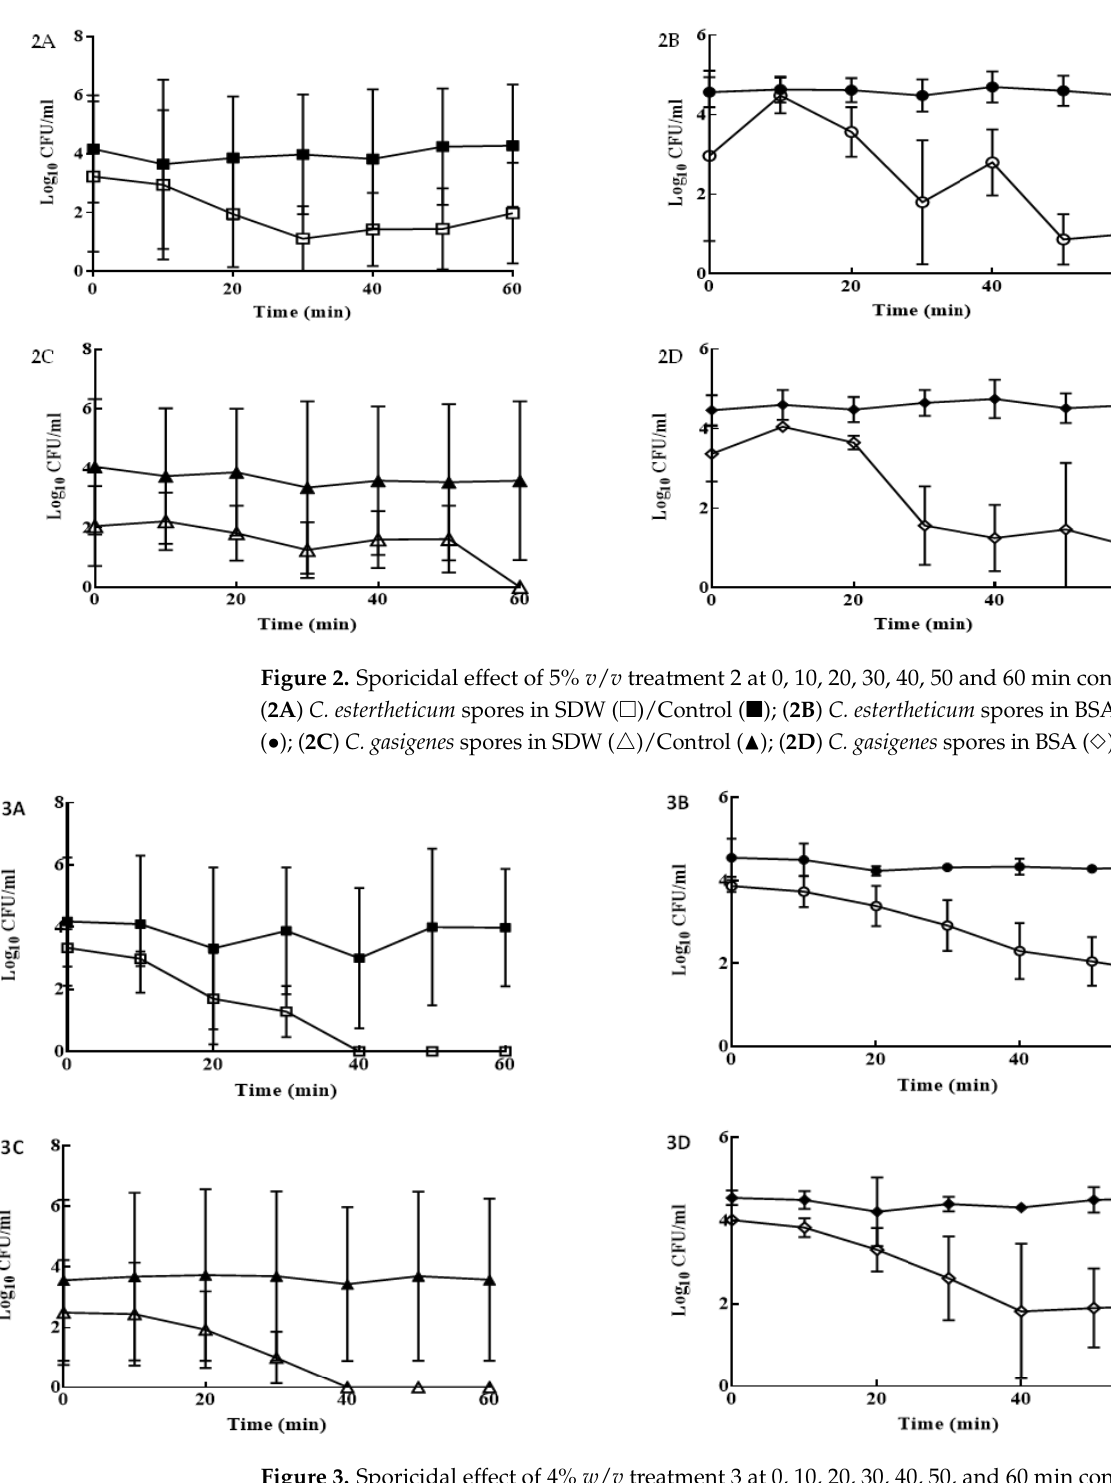
Figure 3. Sporicidal effect of 4% w/v treatment 3 at 0, 10, 20, 30, 40, 50, and 60 min contact times for